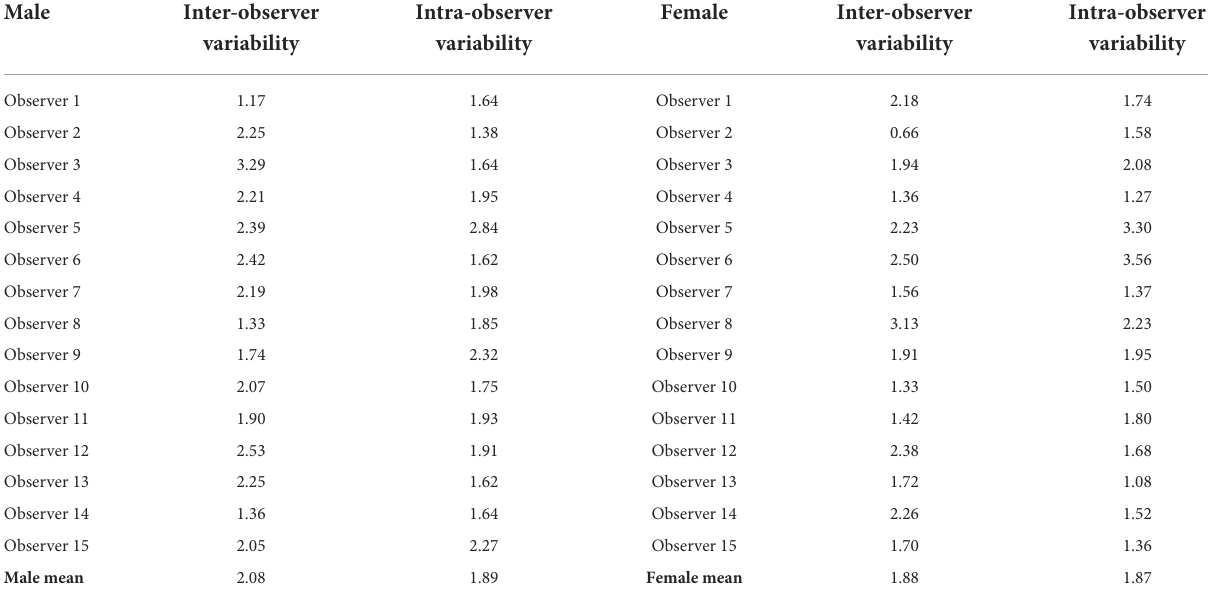
TABLE 5 Inter-observer and intra-observer variability for experiment. Male